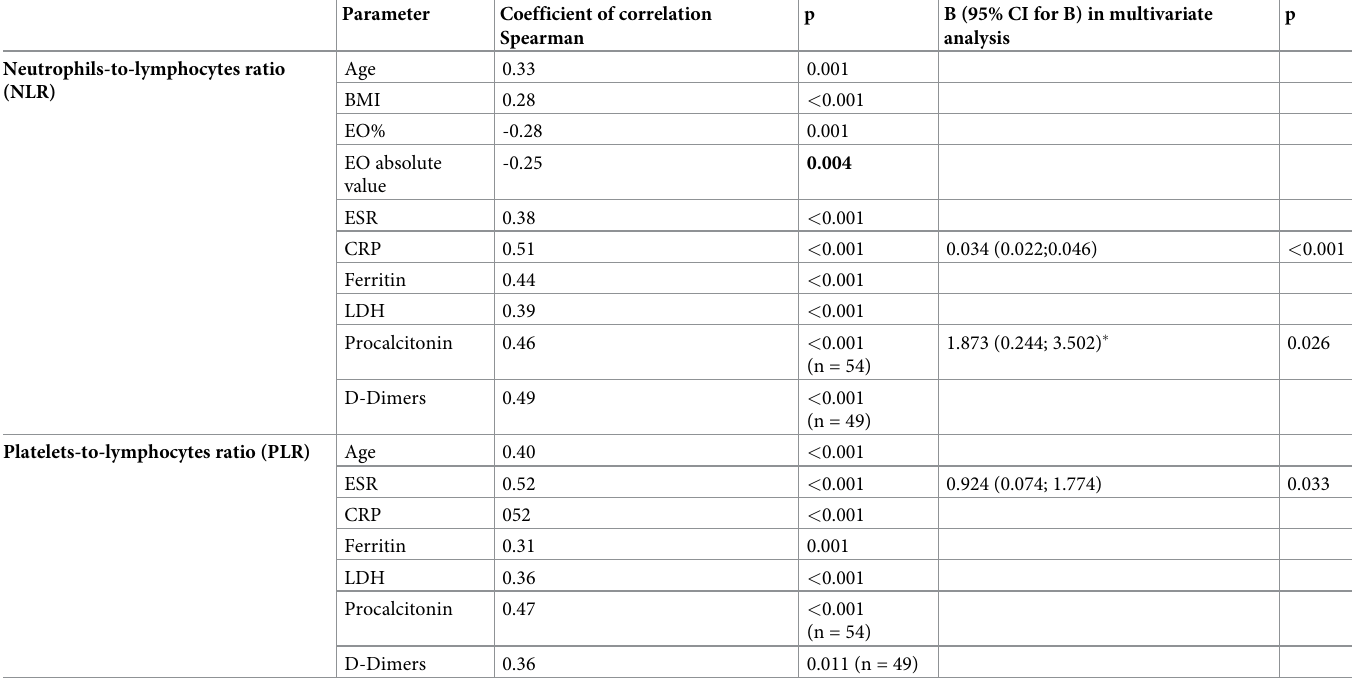
Table 4. NLR and PLR